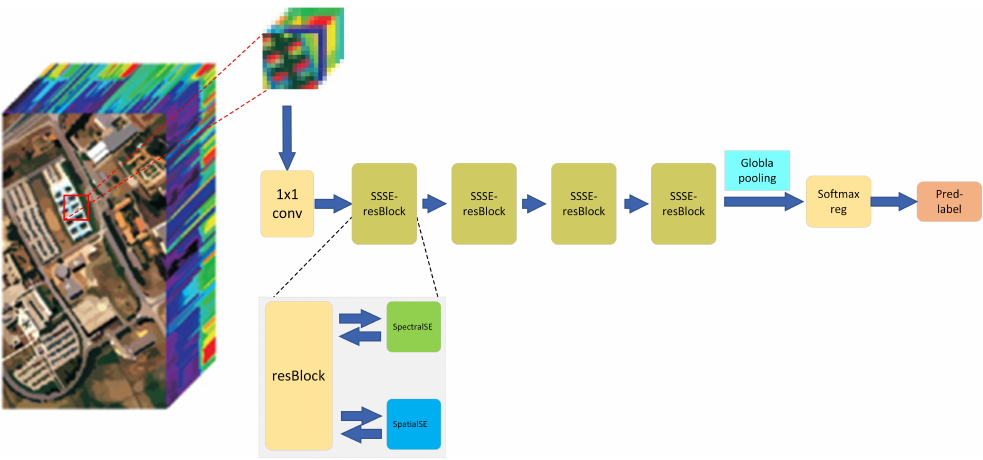
Figure 4. The procedure of the SSSE-based redisual network (SSSERN) method.